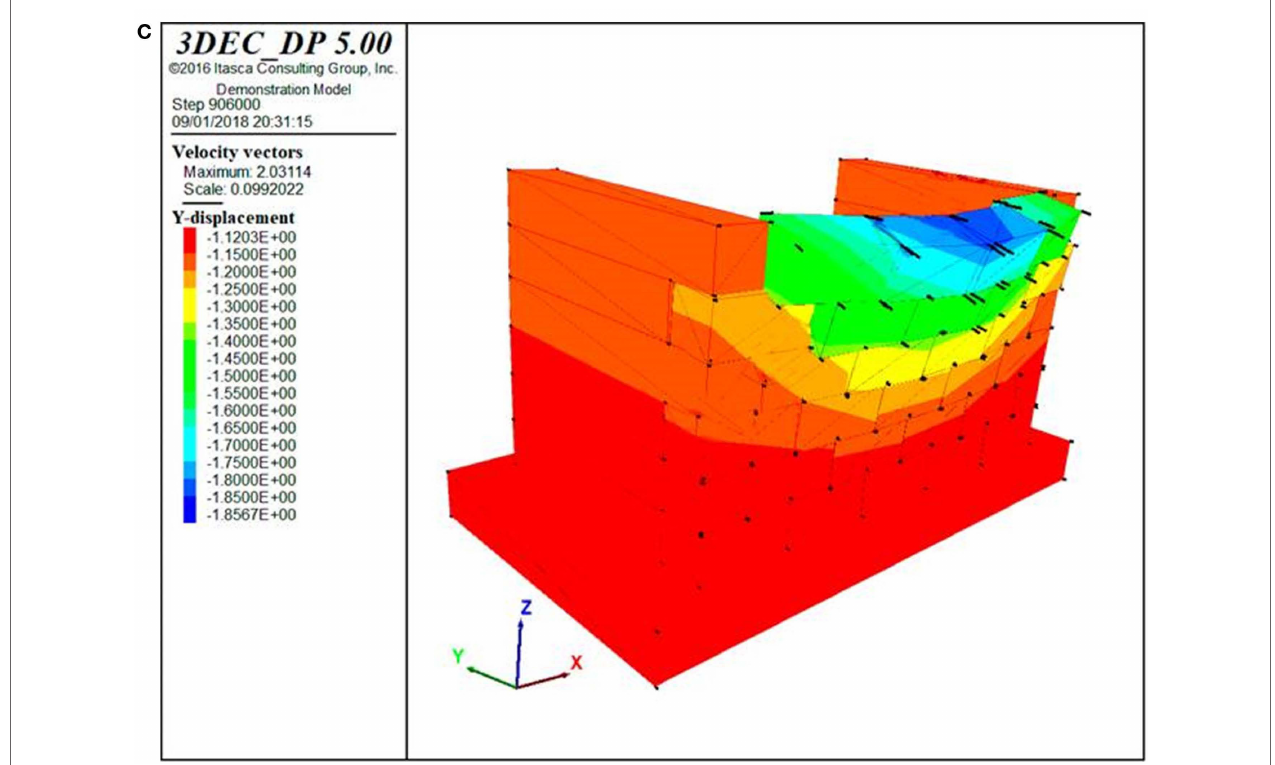
FIGURE 14 | (A) Collapse mechanism for model O1 (0.2g). (B) Collapse mechanism for model O2 (0.12g). (C) Collapse mechanism for model O3